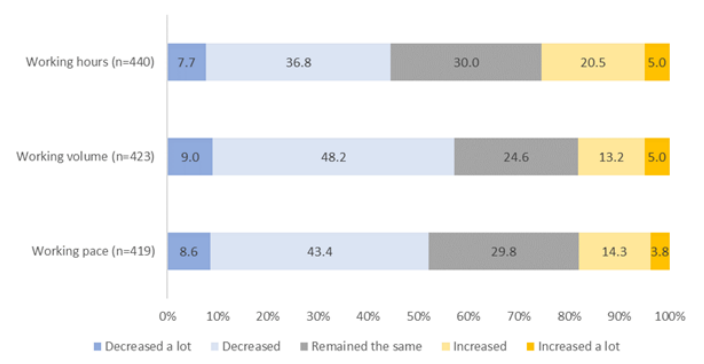
Figure 5: Changes on Working Time and Intensity Within Magistrates (%)